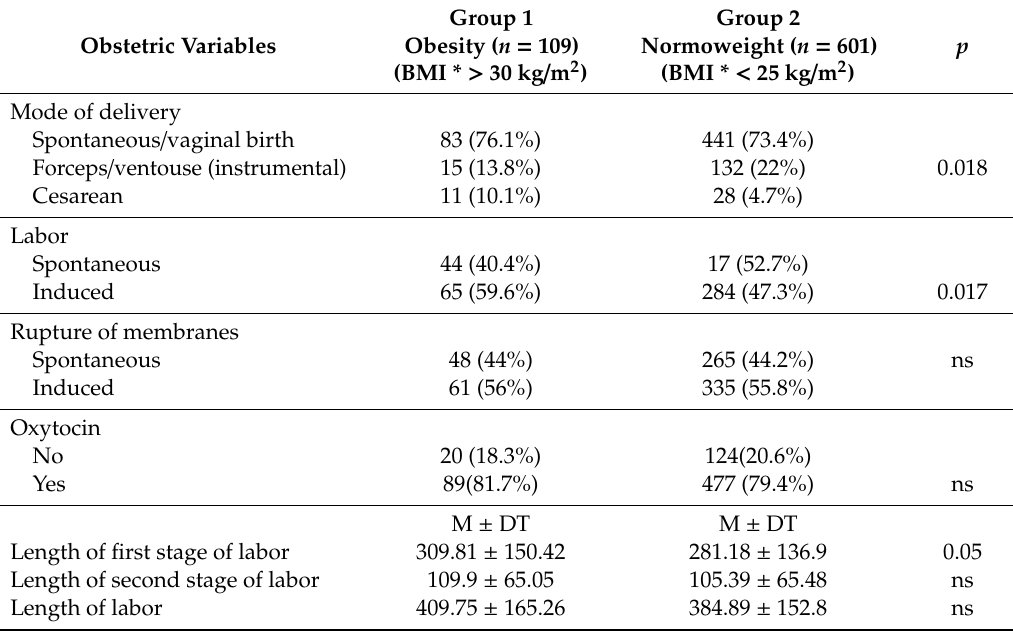
Table 3. Obstetric variables in the normoweight and obesity